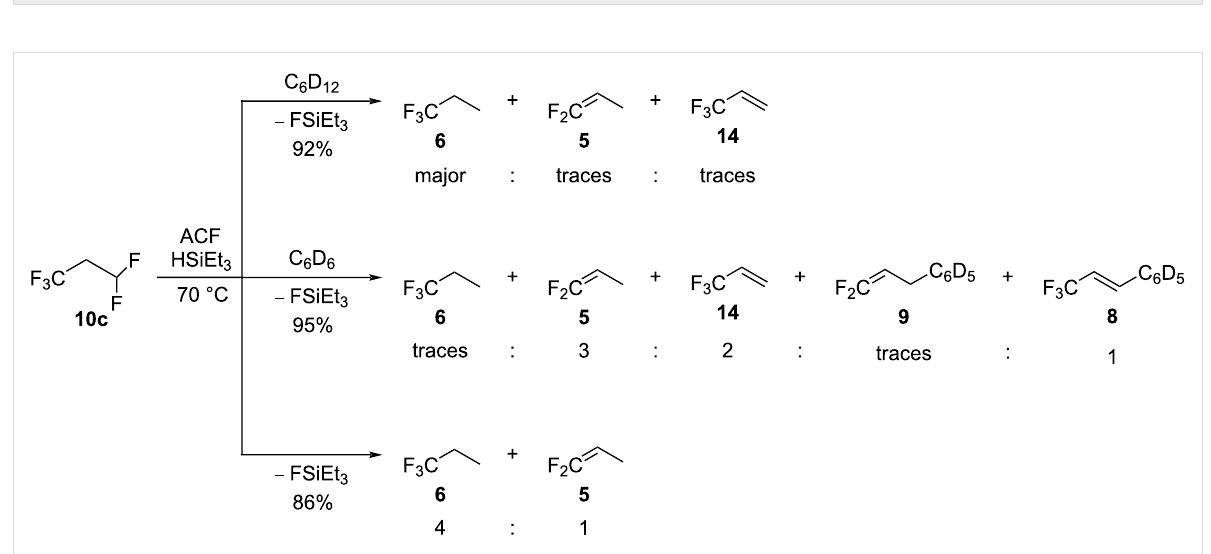
Scheme 10: Proposed catalytic cycles for the transformation of 10c in C 6 D 12 and in the presence of 0.5 equivalents of silane and ACF as the cata- lyst.